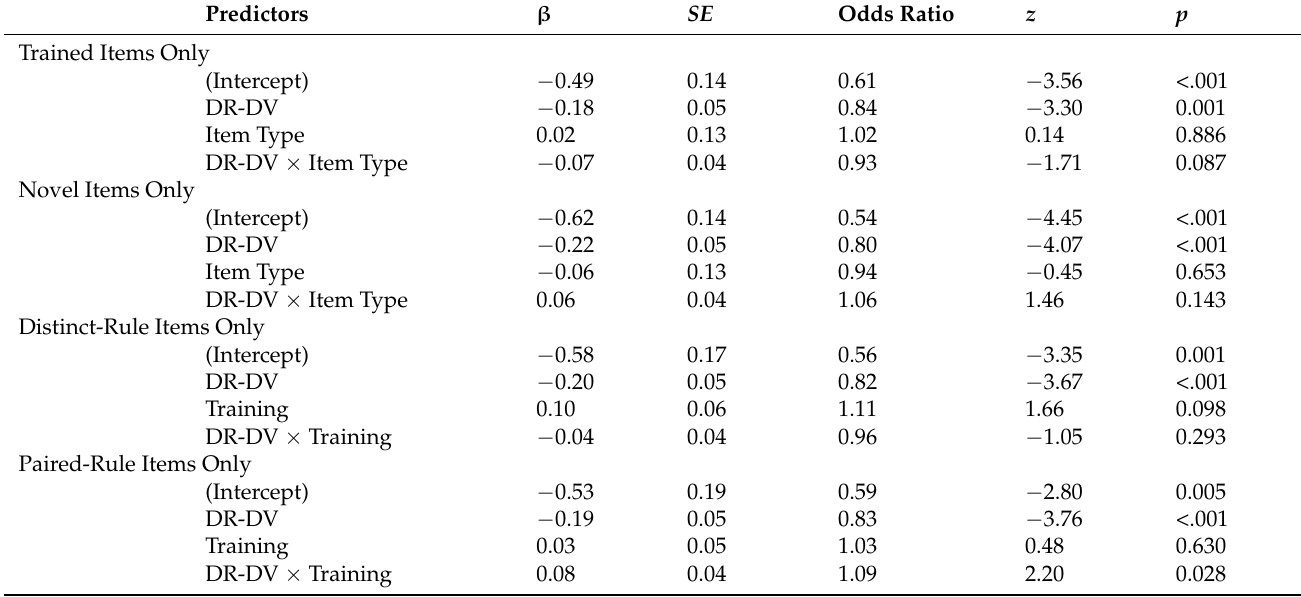
Table A5. Post hoc comparisons: different-rule–different-version × training × item